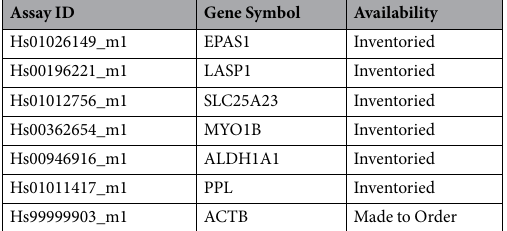
Table 6. TaqMan Gene Expression